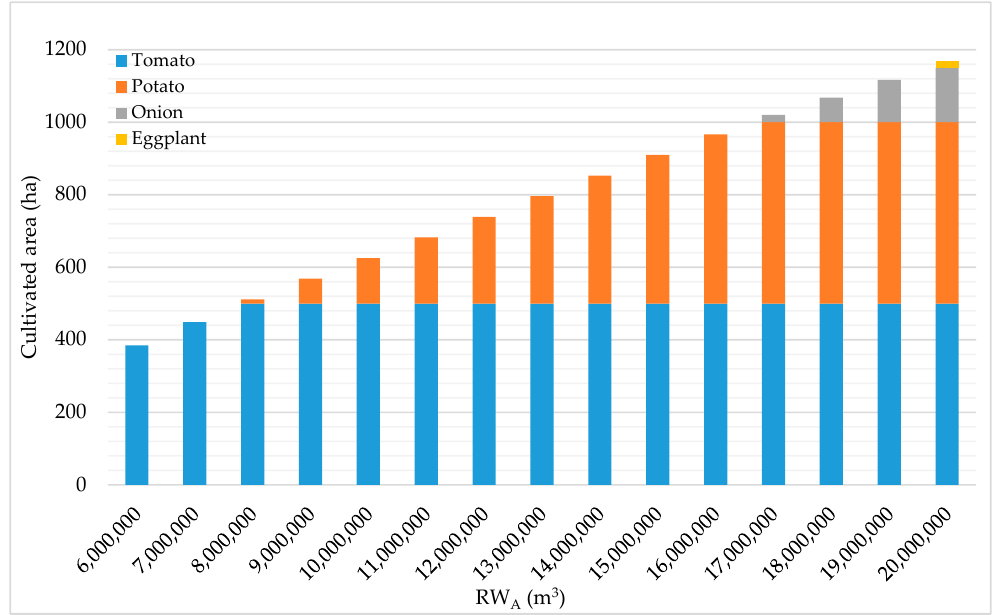
Figure 8. Predicted area (ha) of crops irrigated using reclaimed water type A (RW A ) with 45% IE.